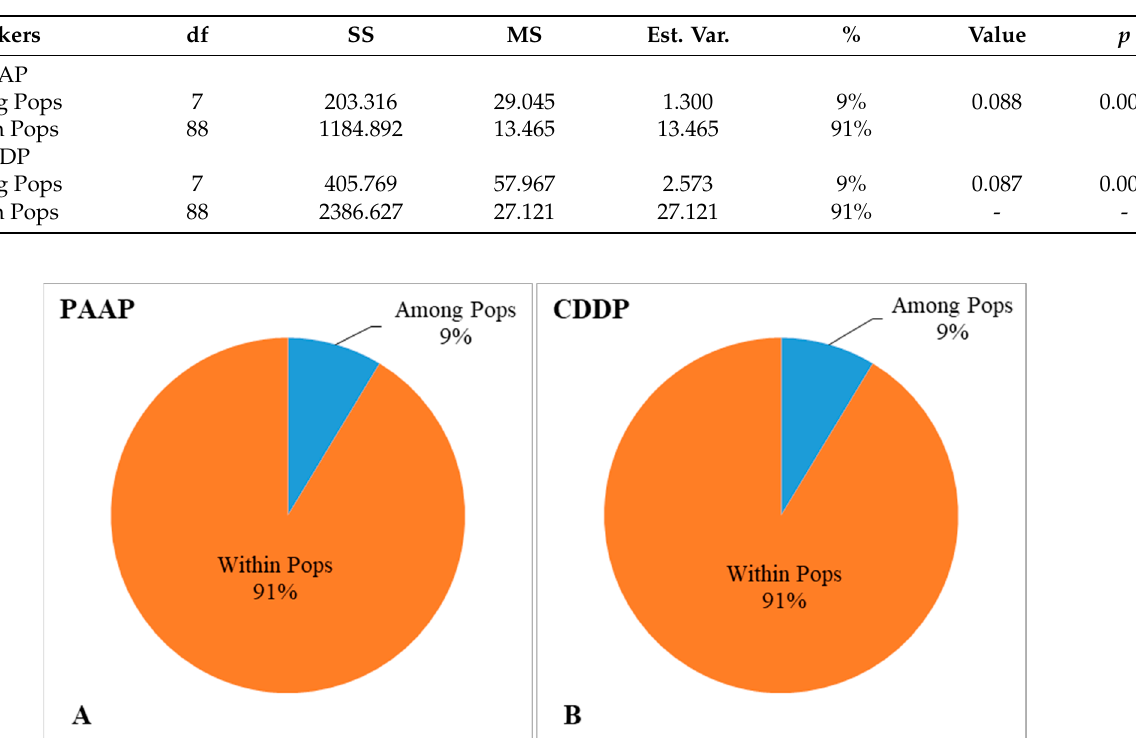
Table 6. Analysis of molecular variance (AMOVA) of A. tsao-ko based on PAAP and CDDP markers.